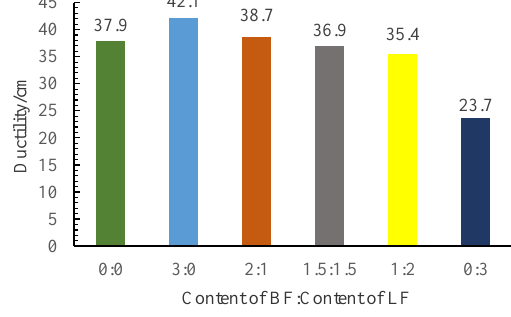
Figure 9. Test results of ductility.